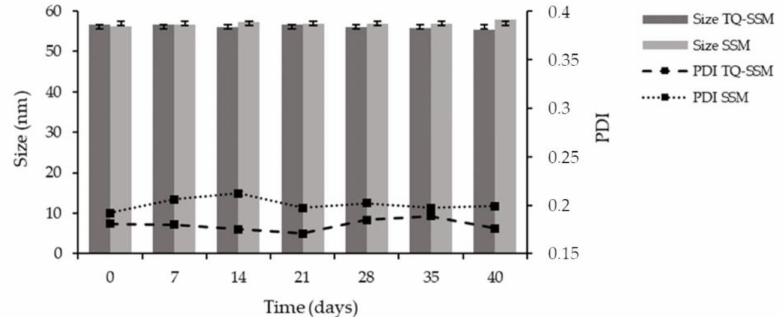
Figure 4. Particle size and polydispersity index (PDI) of TQ-SSM as dispersion after 40 days’ storage at 4 ◦ C. Data displayed as mean ± SD (n =